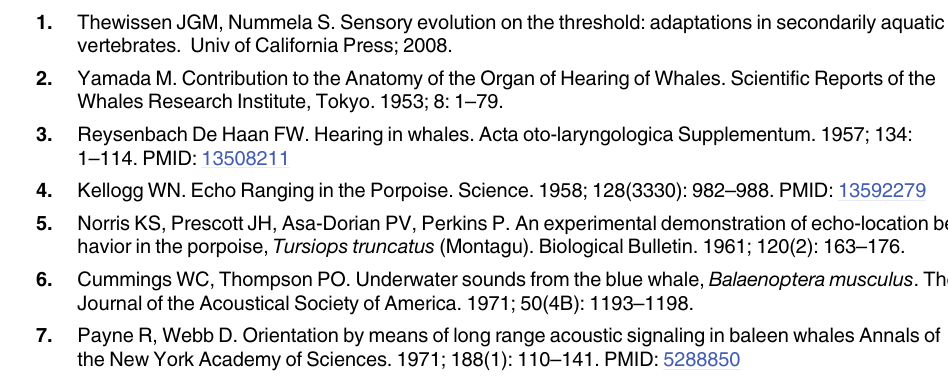
USNM 260585. S2 Fig. The ossification of the tympanoperiotic complex through ontogeny. All CT scanned specimens are represented in this figure. The relative density of the ears is obtained by dividing the maximum CT number of the tympanoperiotic complex by the maximum CT number of the rest of the skull. TL = total length. The newborn length of each species was obtained from [36]. S3 Fig. Developmental stages of the ears as functions of relative length (left panel) and total length (right panel) for all specimens. Refer to S2 Text for descriptions of each stage. S4 Fig. Osteological specimens representing Stage 7 mysticete ears. (a) B . physalus , USNM 269156. (b) Eschrichtius robustus , USNM 593416. Scale bar = 2